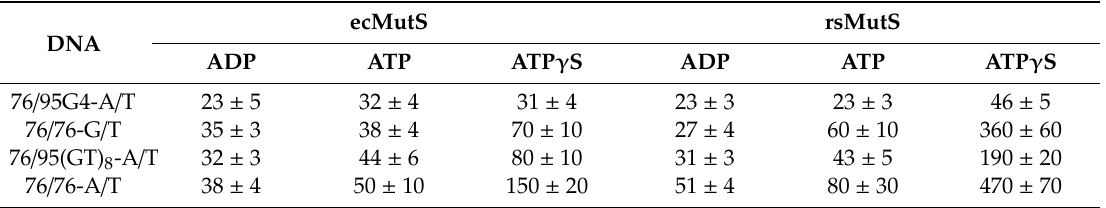
Table 2. Apparent dissociation constants ( K Dapp , nM) for complexes of ecMutS and rsMutS with TAMRA-labeled 76-bp DNA ligands in the presence of ADP, ATP, or ATP γ S. ecMutS DNA